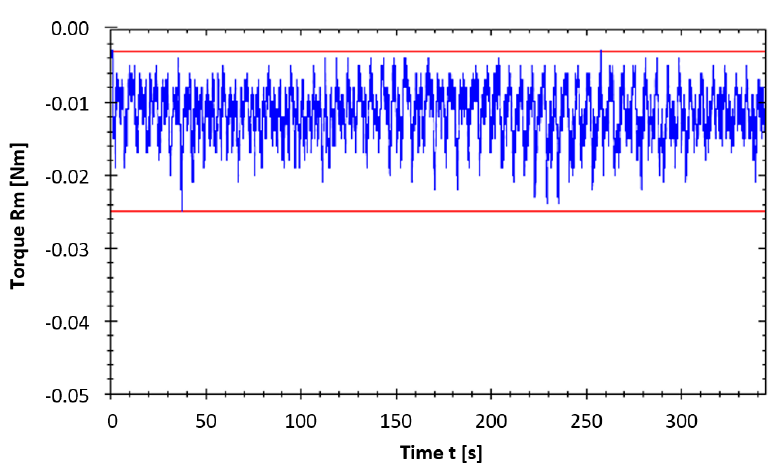
Figure 18. Starting torque (Rm) BR TS 050-63, s/n.1911—CCW direction (after the trial run).